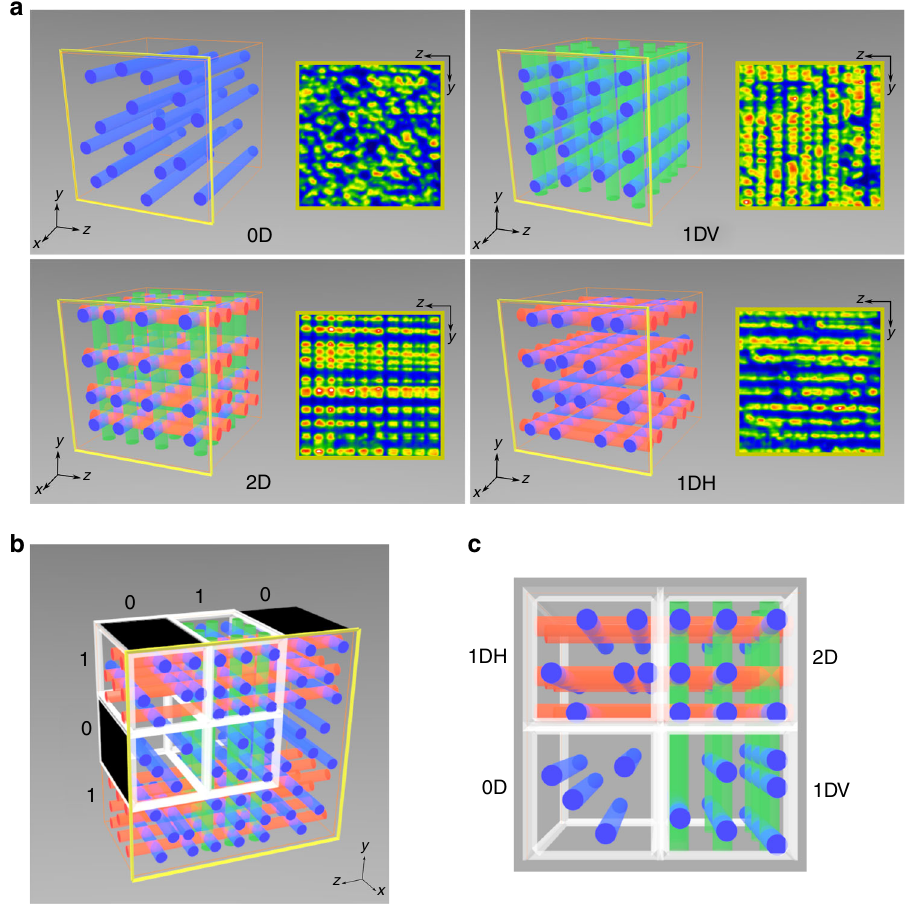
Fig. 1 Working principles of the photopolymer cuboid. Schemes and actual spatial intensity pro fi les of a disordered (0D), one-dimensionally ordered (1DH, 1DV), and two-dimensionally ordered (2D) con fi gurations of carrier fi laments at the output face ( yz plane) of the polymer cuboid. b Simultaneous input of binary strings along the y and z axes divides the cuboid into voxels, each containing a speci fi c con fi guration of carrier fi laments. c The output of voxels containing the four possible fi lament con fi